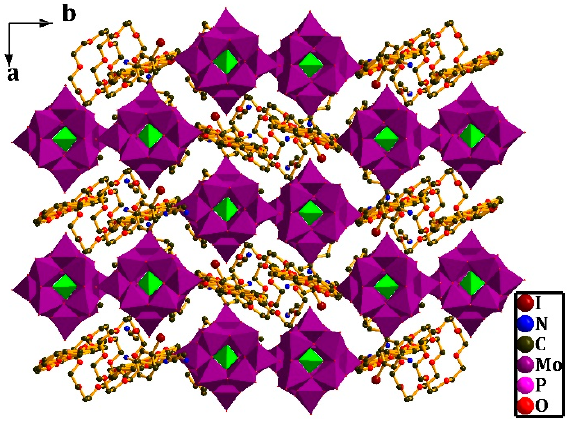
Figure 7. The packing diagram of Crystal 2, viewed along the c -axis.